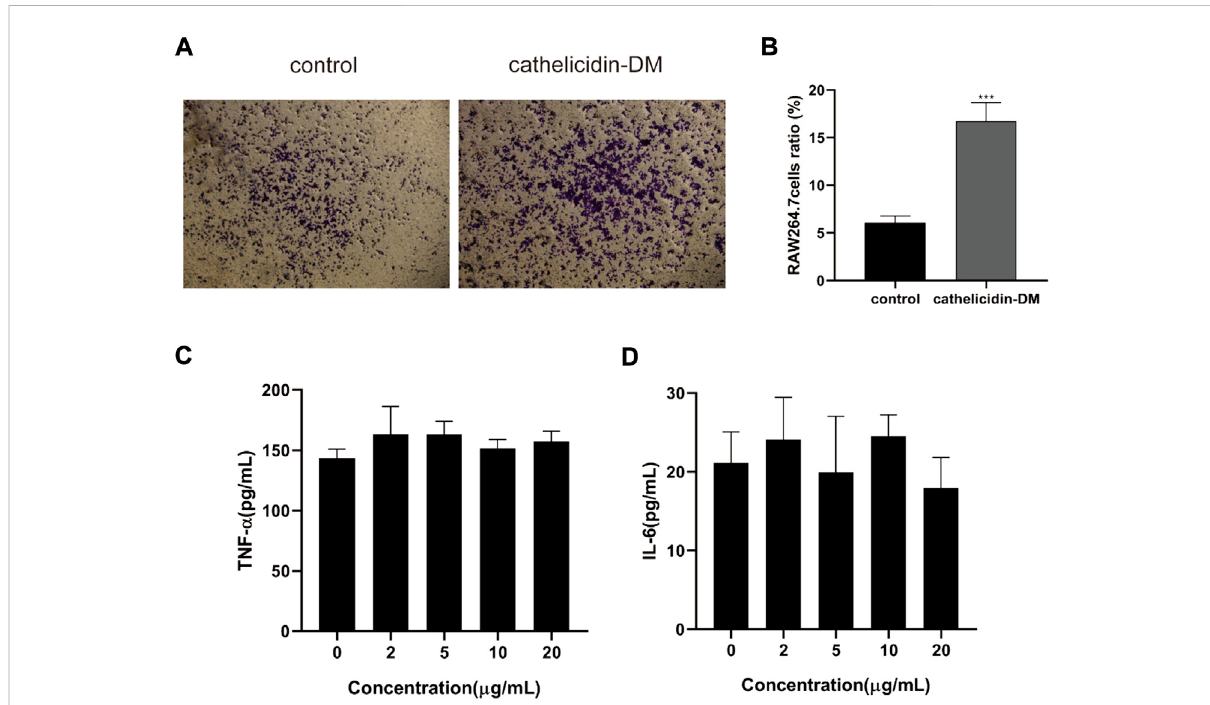
FIGURE 2 Effect of cathelicidin-DM on the migration of mouse RAW264.7 cells and secretion of TNF- α and IL-6. (A) The effect of 20 μ g/ml cathelicidin- DMonthemigratoryactivityofmouseRAW264.7cellswasassayedusingTranswellchambers,Scalebarrepresents100 μ m. (B) Quantitativeanalysis of cells in (A) with ImageJ. (C,D) The effect of different concentrations of cathelicidin-DM on the secretion of TNF- α , IL-6. All the experiments were repeated 3 times and the data are expressed as mean ± standard, * p < 0.05, ** p < 0.01, *** p <